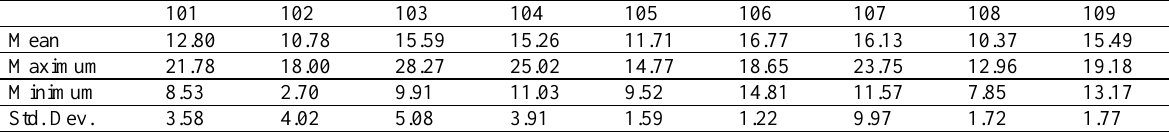
Table 2b: Capital Adequacy Ratio (CAR) of the selected internationalized DMBs: